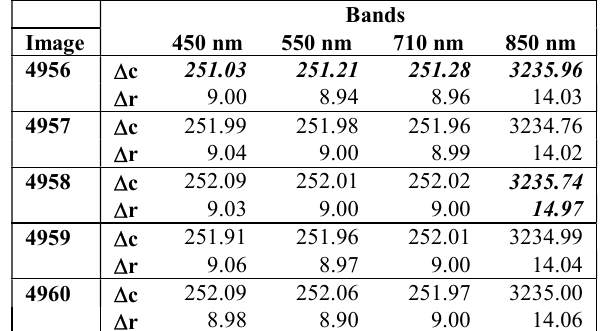
Figure 3. (a) Calibration field with coded targets; (b) Original Table 2. Average values of the origin of crops automatically frame; (c) cropped image to band 710 nm, and (d) band 850 nm. generated. Self-calibrating bundle adjustment was performed using a minimum of seven absolute constraints, defined by the 3D coordinates of two points and the Z coordinate of a third